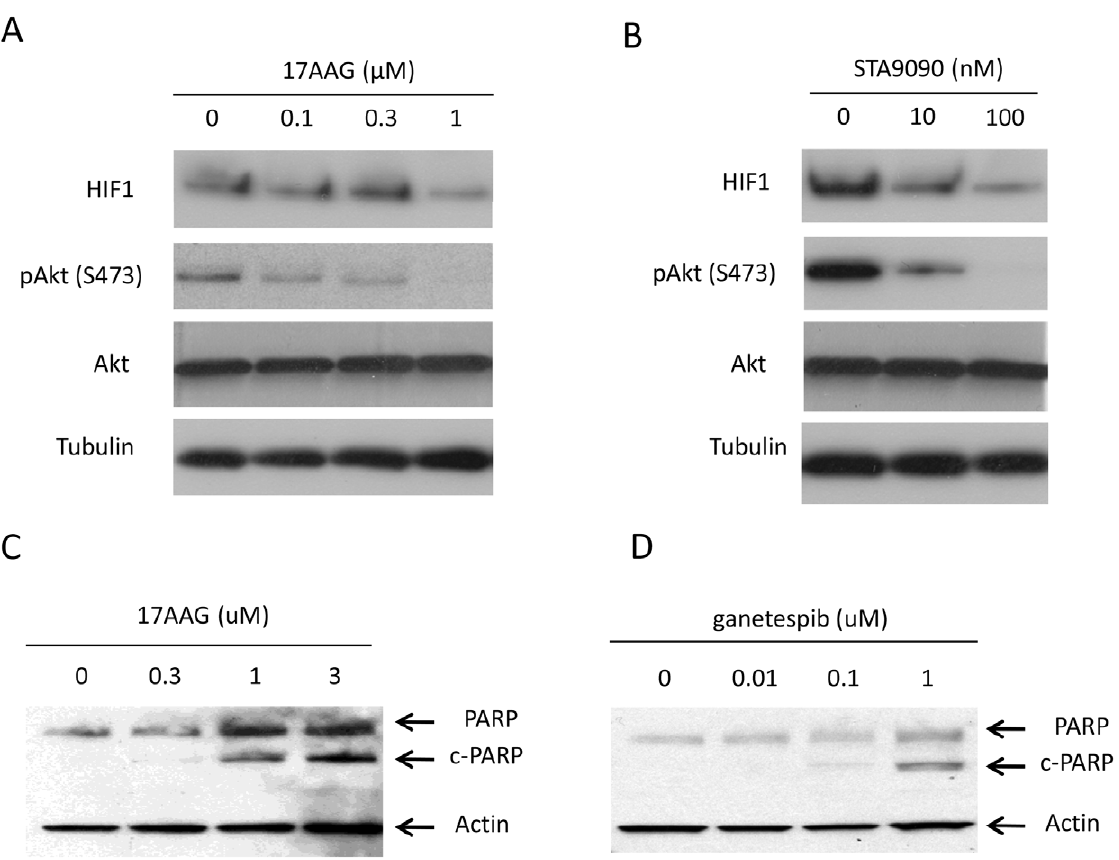
Figure 3. Characterization of Hsp90 client proteins affected by 17-AAG and ganetespib. MTT cells were treated with different doses of 17- AAG (A) or ganetespib (B) (0.1, 0.3, and 1 m M 17-AAG for 20 hours; 10 nM and 100 nM ganetespib for 20 hours) and total cell lysates were analyzed by western blotting. Control cells (0) were treated with DMSO vehicle alone for the same time. 17-AAG and ganetespib induce PARP cleavage in pheochromocytoma MTT cells. MTT cells were cultured with the indicated amount of 17-AAG (C) or ganetespib (D) for 20 hours and total cell lysates were subjected to western blot for PARP and reblotted for actin.